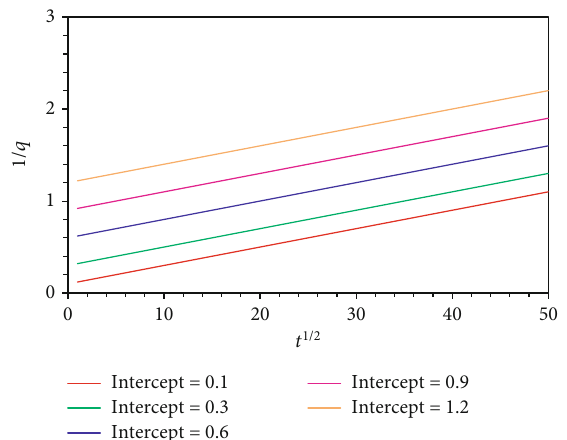
Figure 15: Cases with varied intercept and same slope.